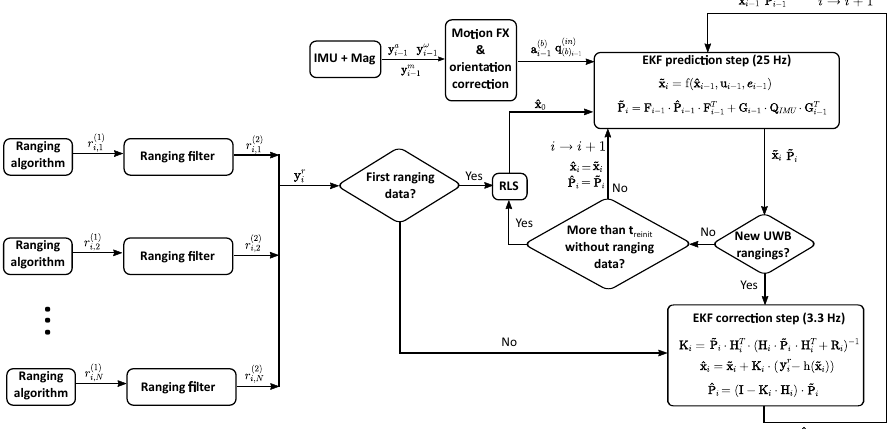
Figure 6. Flow chart of the EKF that fuses the UWB data with an inertial measurement unit (IMU) and